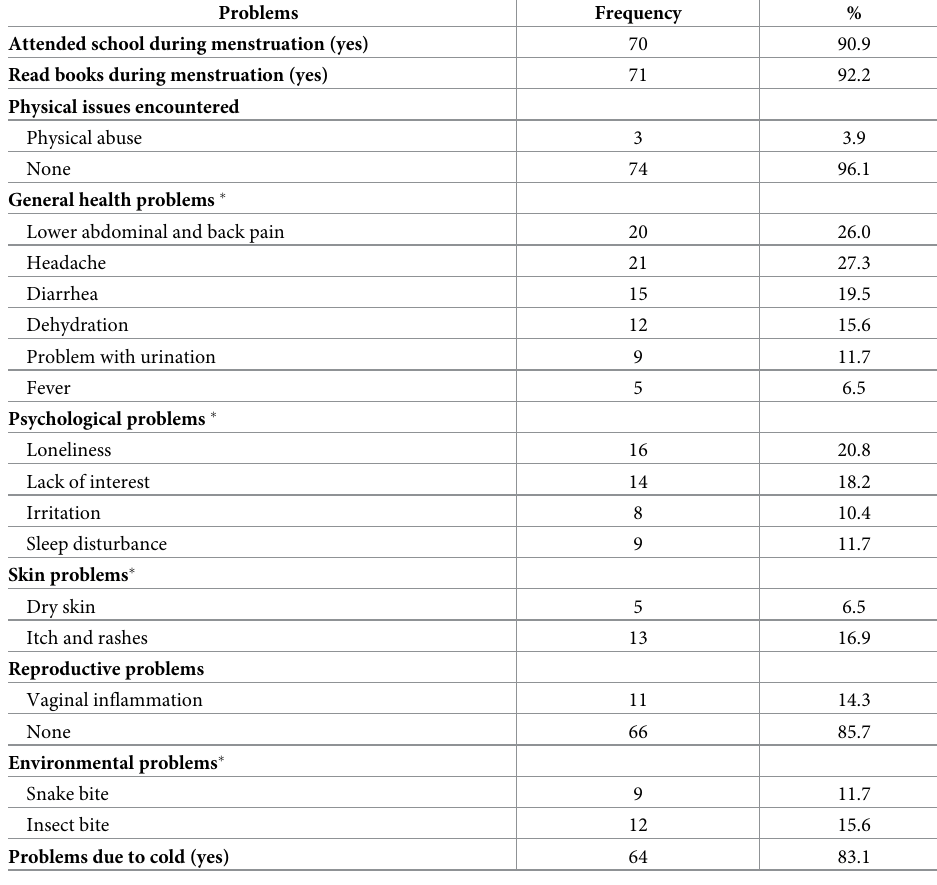
Table 3. Problems experienced by participants during Chhaupadi (N =